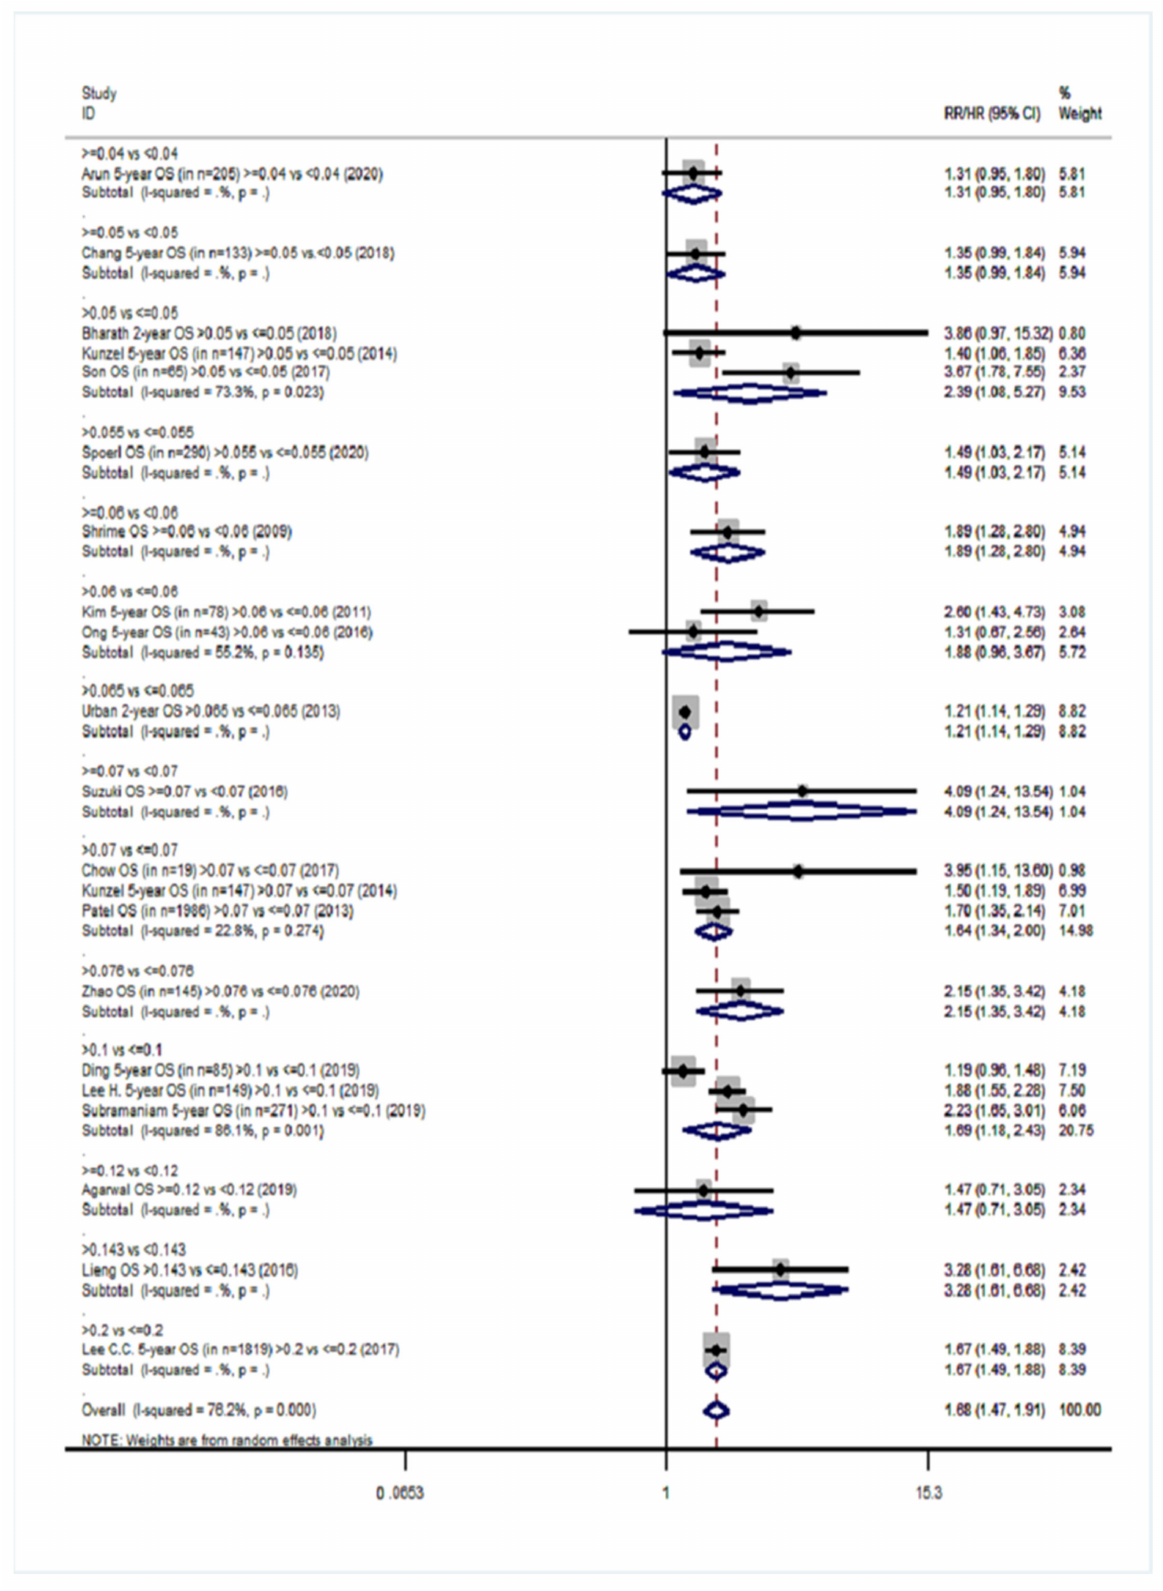
Figure 2. Forest plot describing the associations between lymph node ratio (LNR) and overall survival (OS) in group YES. Apart from the overall analysis, the subanalyses by LNR cut-off values are